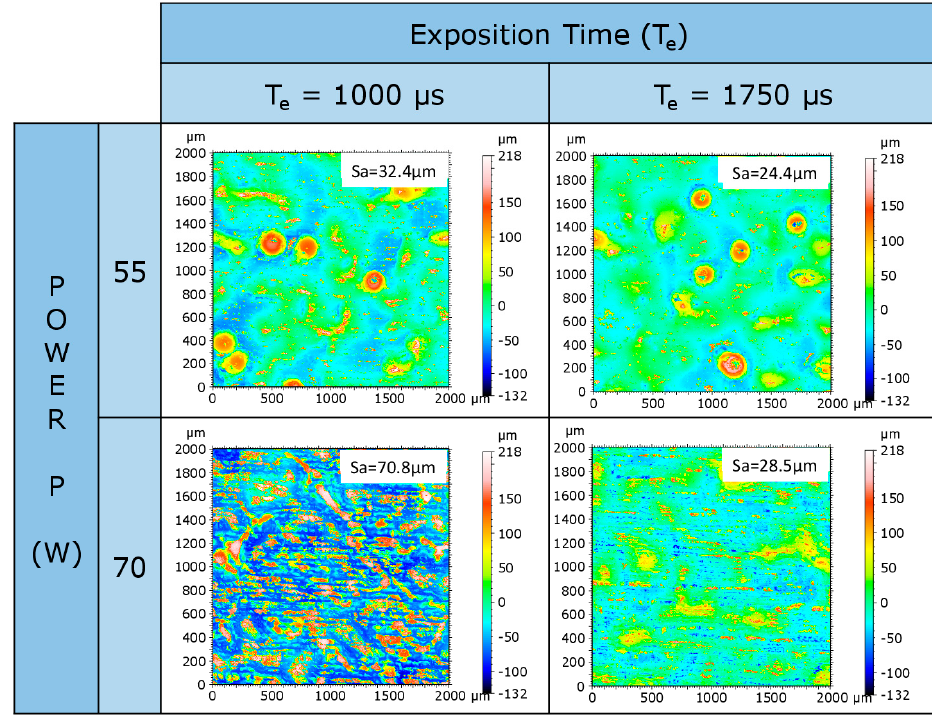
Figure 12. Topographic measures of extreme samples from N° 1 to N° 16.